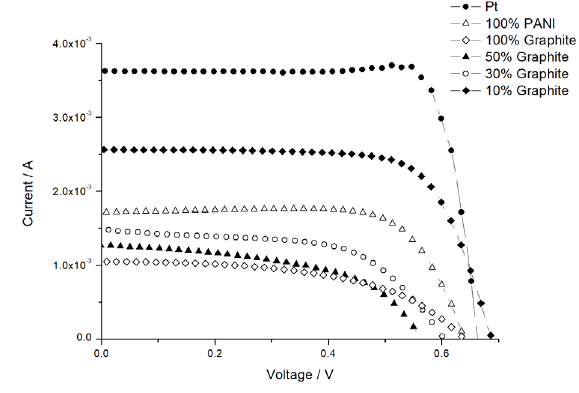
Figure 5: Photocurrent-voltage characteristics with different Graphite/PANI ratios and standard Pt electrode. Table 1: Photocurrent-voltage characteristics with different Graphite:PANI ratios compared to Pt counter. Counter